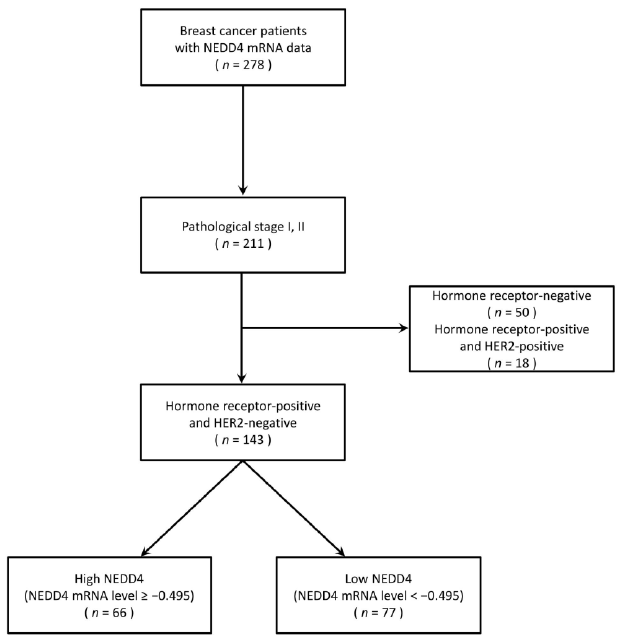
Figure 1. Flow diagram of breast cancer patients whose expression level of NEDD4 mRNA was measured. Table 1. Clinicopathological characteristics of the patients with HR-positive HER2-negative breast cancer, classified into high and low NEDD4 mRNA groups.